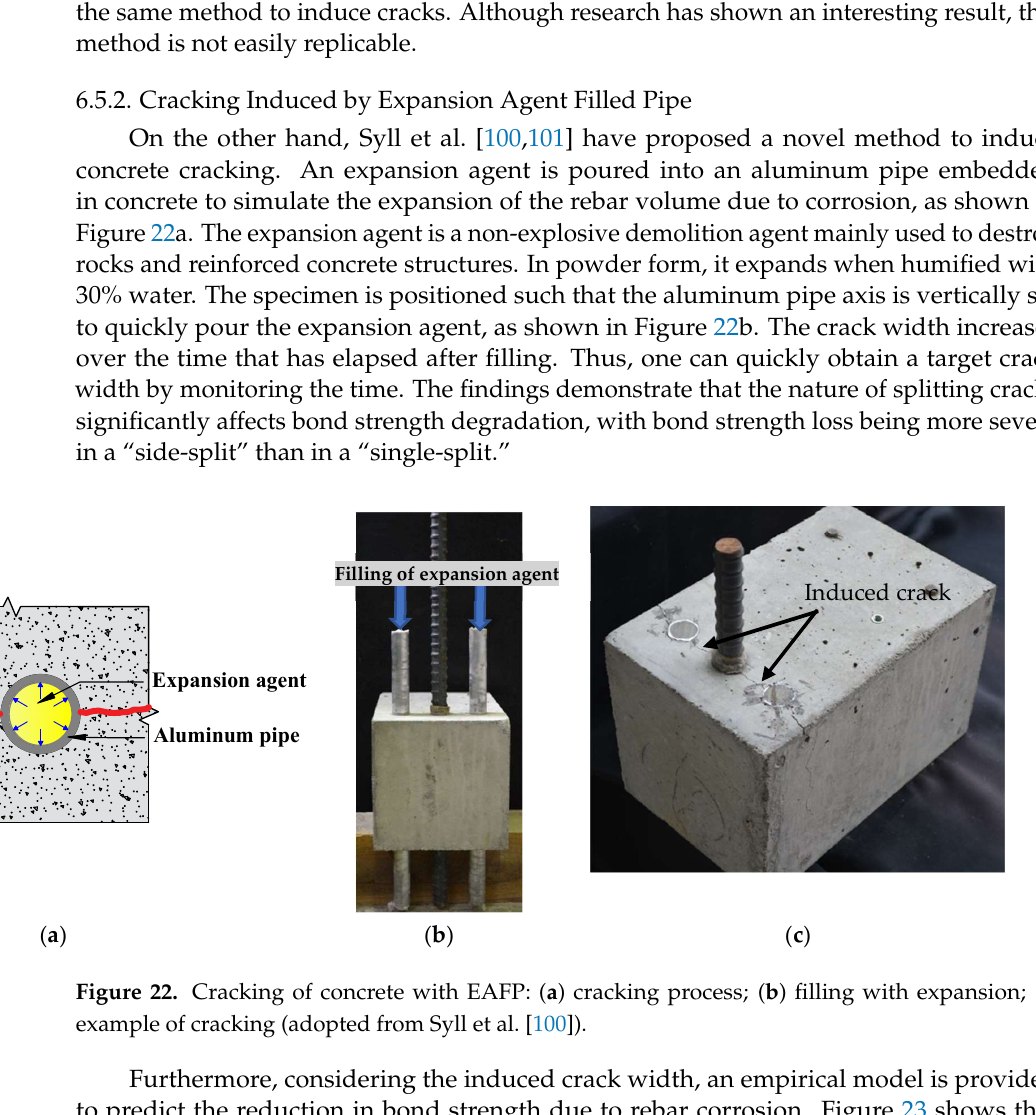
Figure 23. Comparison of Syll et al. [100] formulas with experimental results from the literature [73,74,76].